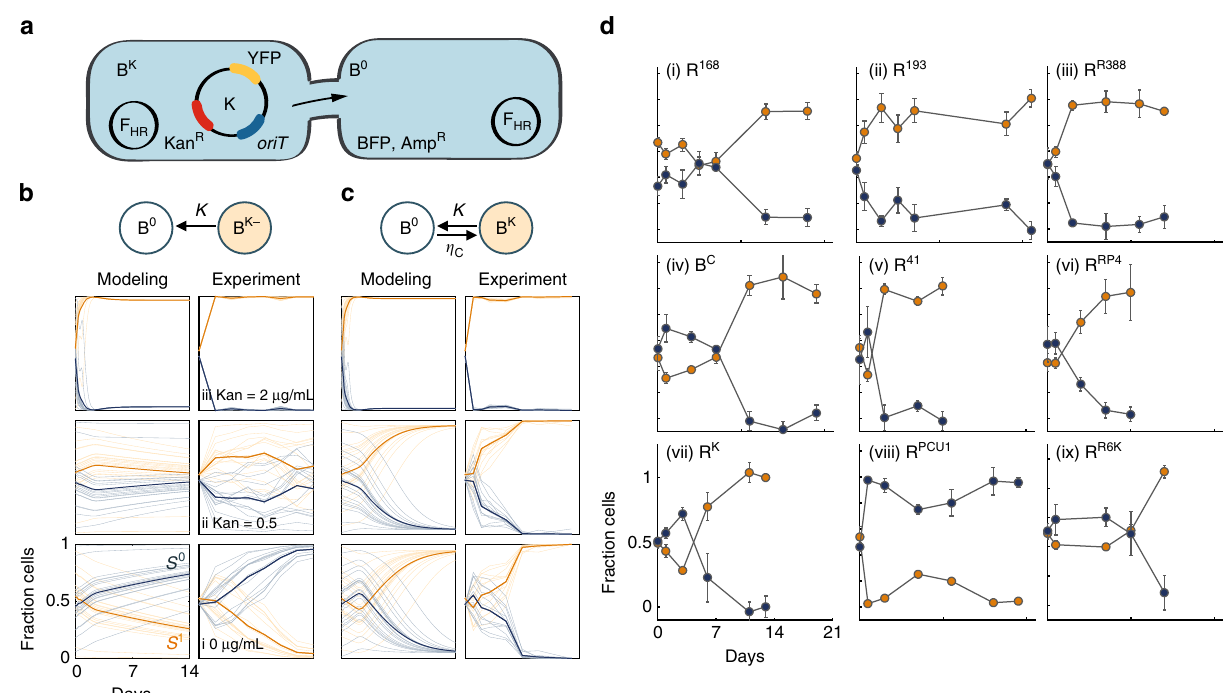
Fig. 2 Conjugation-assisted persistence of costly plasmids. For all modeling and experimental results, x -axis is days and y -axis is fraction of cells. a Engineered conjugation. The background strain, B, expresses BFP and Amp R constitutively 45 . B carries the helper plasmid F HR (B 0 ), which is non-self- transmissible, but can mobilize plasmids in trans. The mobile plasmid K carries the transfer origin ( oriT ), a kanamycin-resistant gene (Kan R ), and yfp under the control of strong constitutive promoter P R 44 . When B carries K, it is denoted B K . K without transferability (i.e., without oriT ) is denoted K − , and when carried by B, B K − . b Long-term dynamics without conjugation. Blue represents plasmid-free and orange plasmid-carrying cells. Shaded lines indicate different initial conditions generated by a strong dilution experimentally (~80 cells/well, 16 wells), or randomly chosen from a uniform distribution (total initial density maintained at 1 × 10 − 6 , 20 replicates). Bold lines are the average across all initial conditions of corresponding color. Modeling (left): i – iii is α = 1.02, 0.97, and 0.42, respectively, estimated from experimental measurements (Supplementary Fig. 1C). Experiment (right): i – iii is Kan = 0, 0.5, and 2 μ g/ mL. Quanti fi cation is performed using fl ow cytometry, where the orange lines are cells expressing both BFP and YFP (B K − ), and the blue line are cells expressing BFP only (B 0 ). c Long-term dynamics with conjugation. Experiments were done identically to (B), with B K instead of B K − . Without antibiotics, the plasmid-carrying population dominated despite the plasmid cost, exhibiting conjugation-assisted persistence. All modeling parameters are identical except ¼ 0 : 025 h − 1 . d Nine conjugation plasmids carried by species R (except C with B 0 , which behaves similarly, Supplementary Fig. 3D) exhibit for η C conjugation-assisted persistence. R 0 was mixed in equal fraction with R P (P for plasmid generality) and diluted 10,000× daily. CFU from four-to-six double- selection plates were divided by the total number of colonies averaged across four-to-six Cm plates for quanti fi cation. Experiments are repeated at least twice. Error bars represent the standard deviation of the four-to-six measurements. The plasmids used are (i) #168, (ii) #193, (iii) R388, (iv) C, (v) #41, (vi) RP4, (vii) K, (viii) PCU1, and (ix) R6K (see Supplementary Tables 1 and